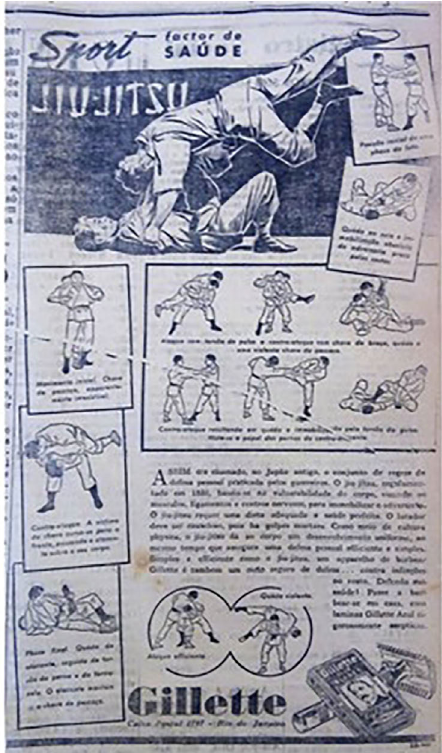
Figure 1 - Gillette advertisement featuring jiu-jitsu. Source: Gazeta do Norte (Minas Gerais). Saturday, 22 June 1940, p.